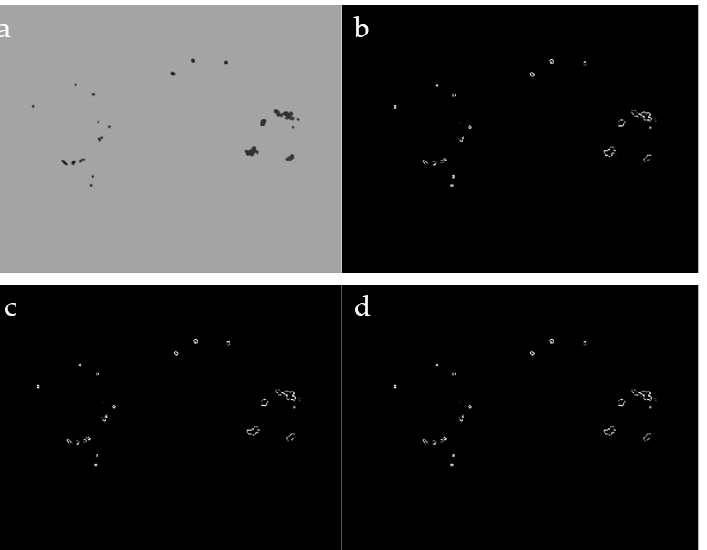
Figure 10. Output of each step of features phase: hue ( a ), std_intensity ( b ), standard deviation of intensity ( c ), and Y channel ( d ). Table 1. Suggested set of features for the FCM classifier.